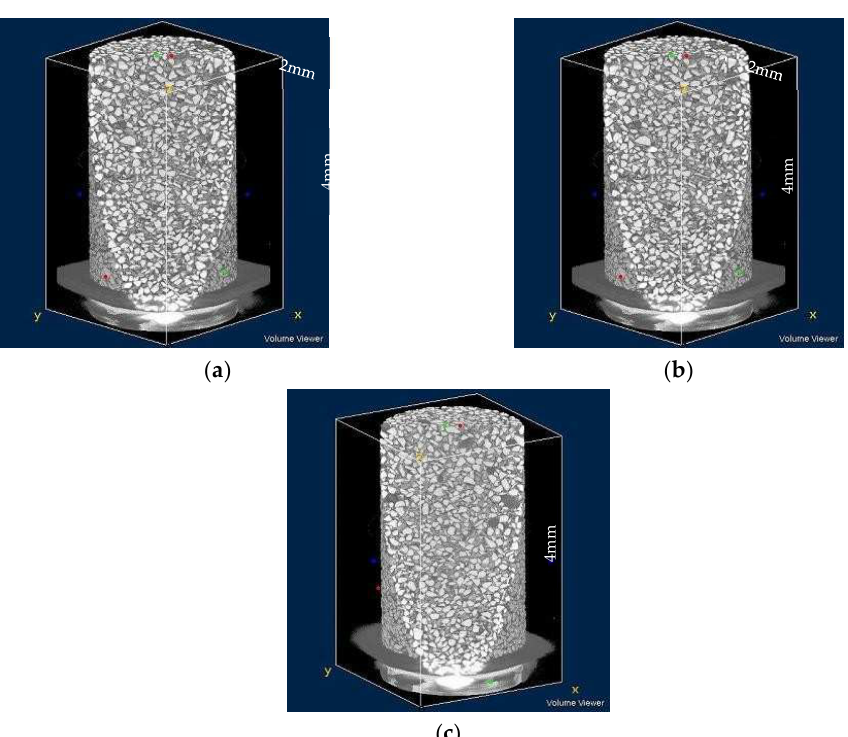
Figure 14. Micro-CT scan images for ( a ) loose, ( b ) medium-dense and ( c ) dense specimens for 10% fines content.